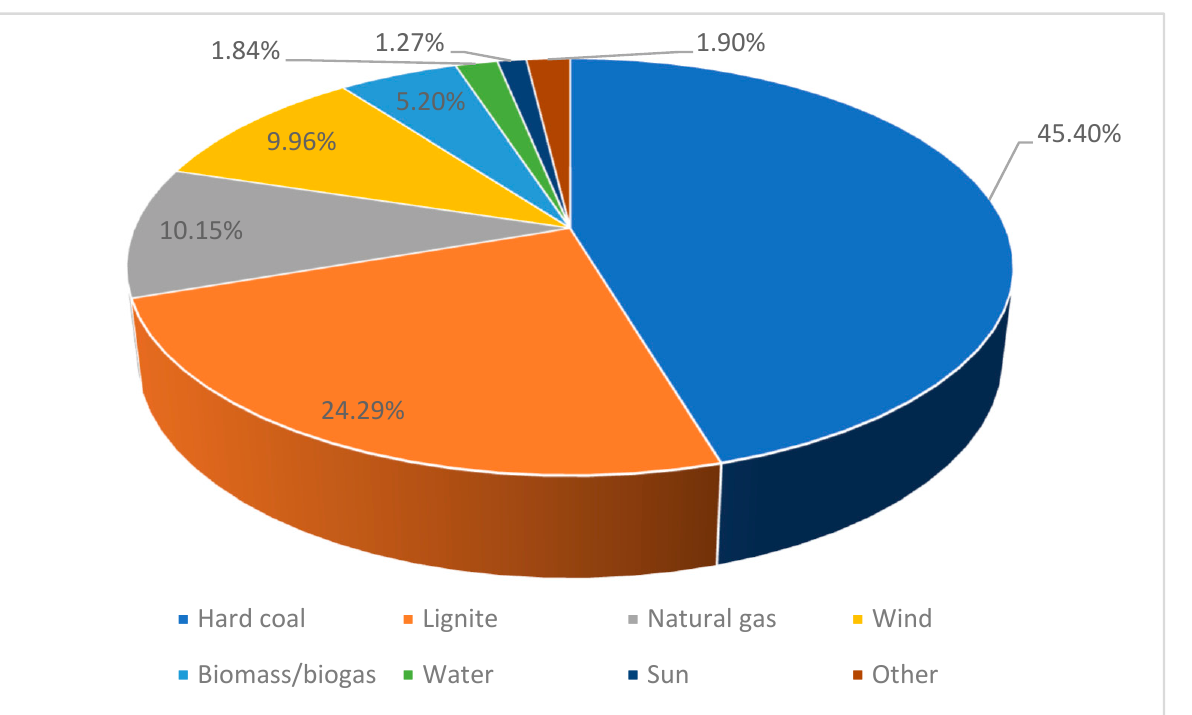
Figure 1. Share of sources in the overall energy balance in Poland (2020). Reproduced from [73], Centrum Informacji o Rynku Energii: 2021.